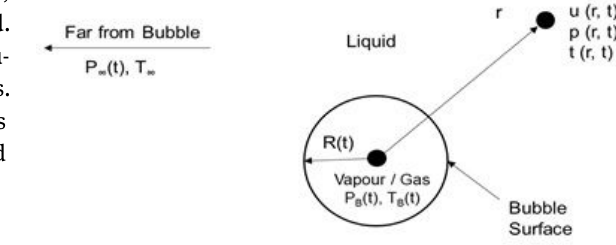
Figure 3: Schematic of a spherical bubble in an infinite